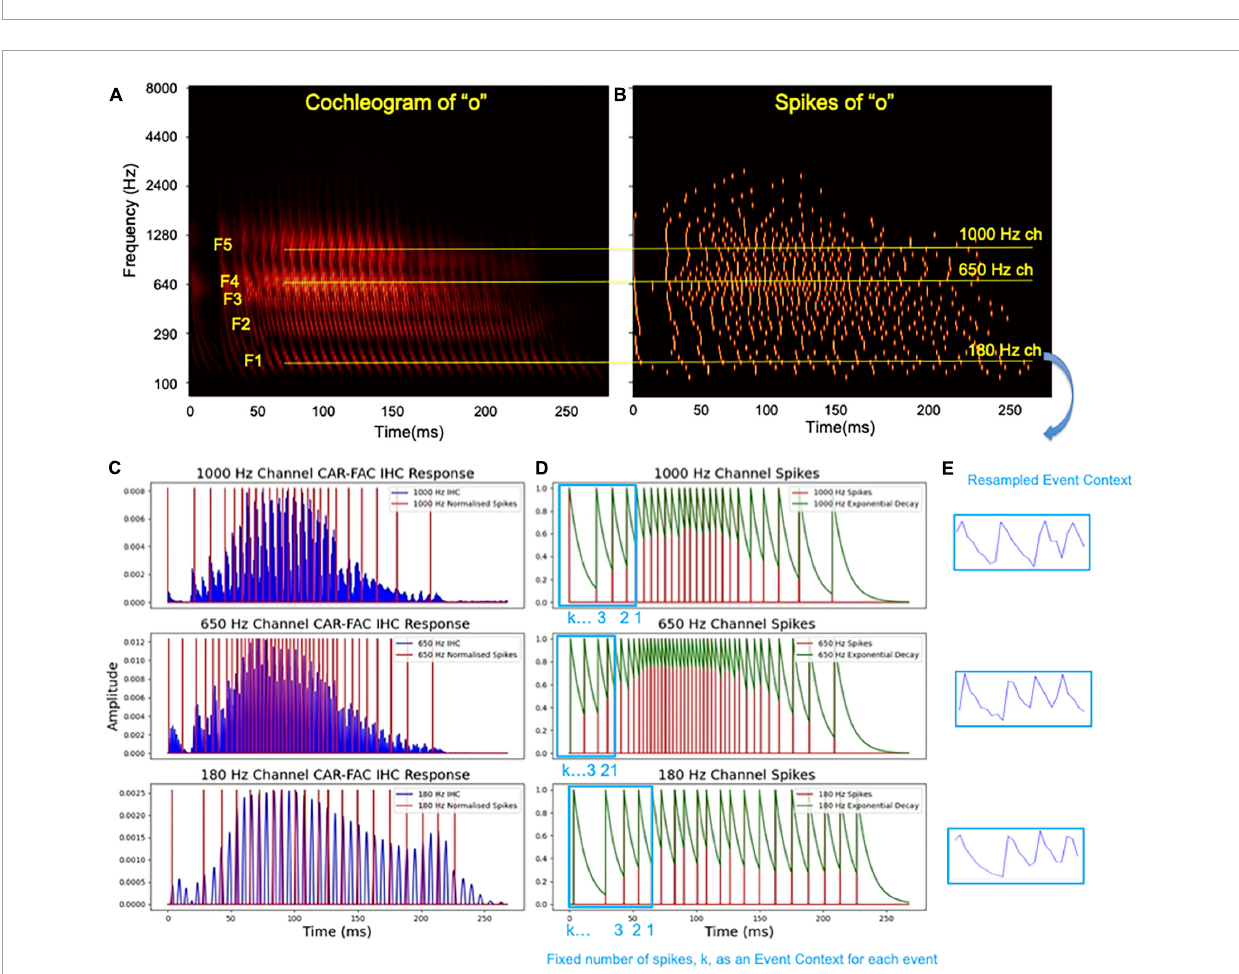
FIGURE4 The CAR-FAC output of utterance “o,” (A) formants (F1-F5) are labeled and three channels, 180 Hz, 650 Hz, and 1000 Hz, are highlighted in yellow; (B) the spikes of utterance “o”; (C) the IHC output from CAR-FAC and the generated spikes encoding amplitude of the three highlighted channels; (D) the time surfaces in these channels; (E) the resampled E_Cs that preserves temporal information.